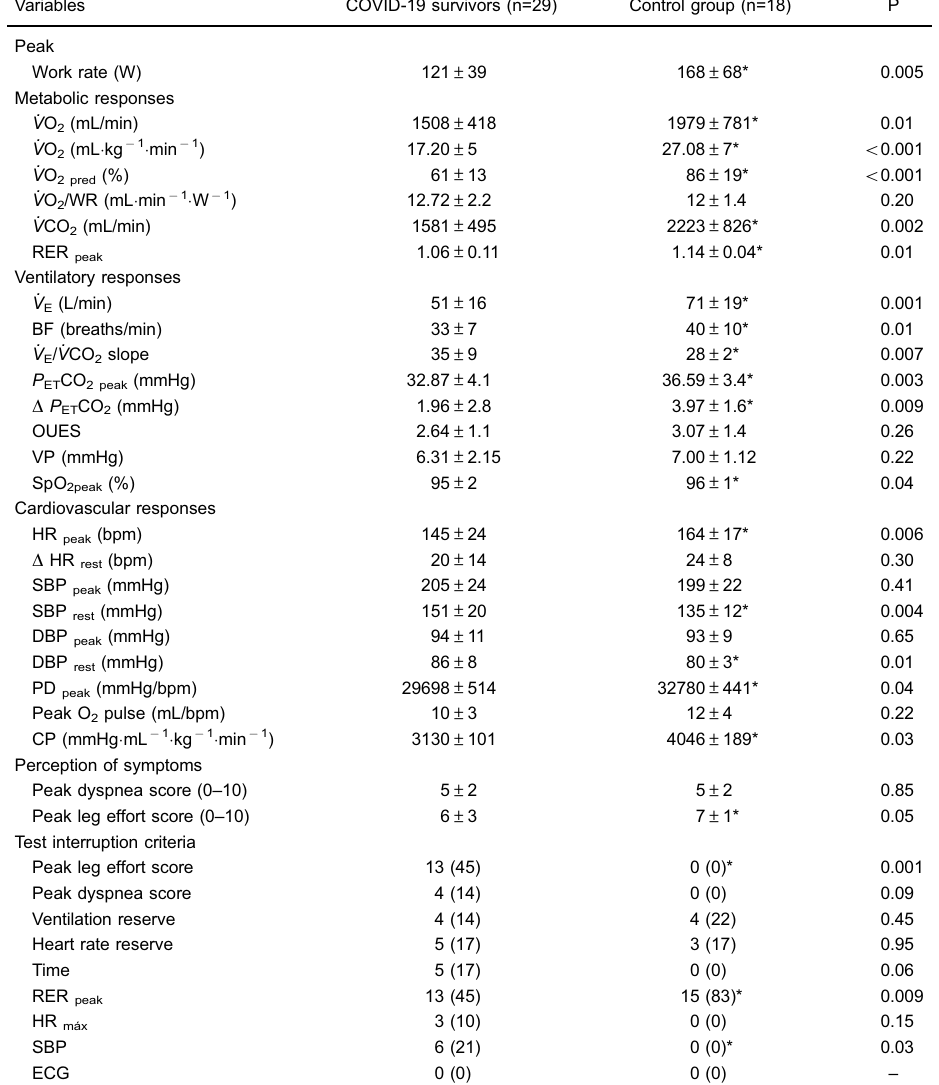
Table 2. Between-group comparison of responses at peak and recovery from cardiopulmonary exercise